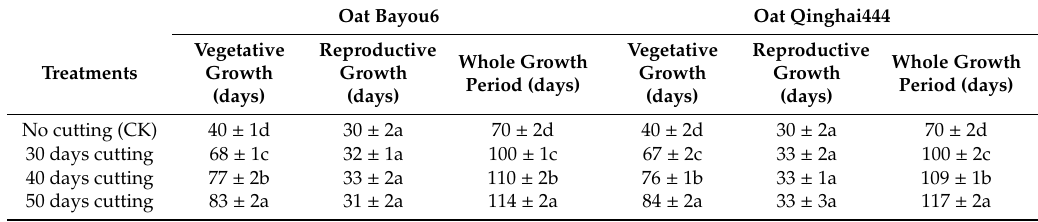
Figure 5. The cumulative dry weight ( a , c ) for the di ff erent cutting stages and the growing stages by Zadoks code ( b , d ) for those oats without cutting during the growing season. Data are means ± SE ( n = 4). Table 4. E ff ects of cutting stage on growth days for oat species of Bayou6 and